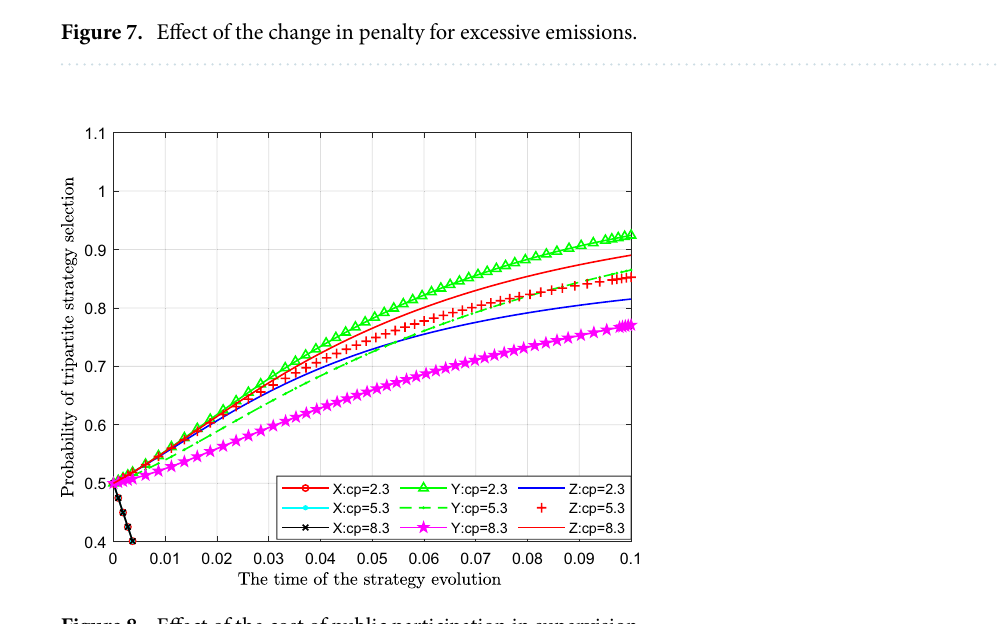
Figure 8. Effect of the cost of public participation in